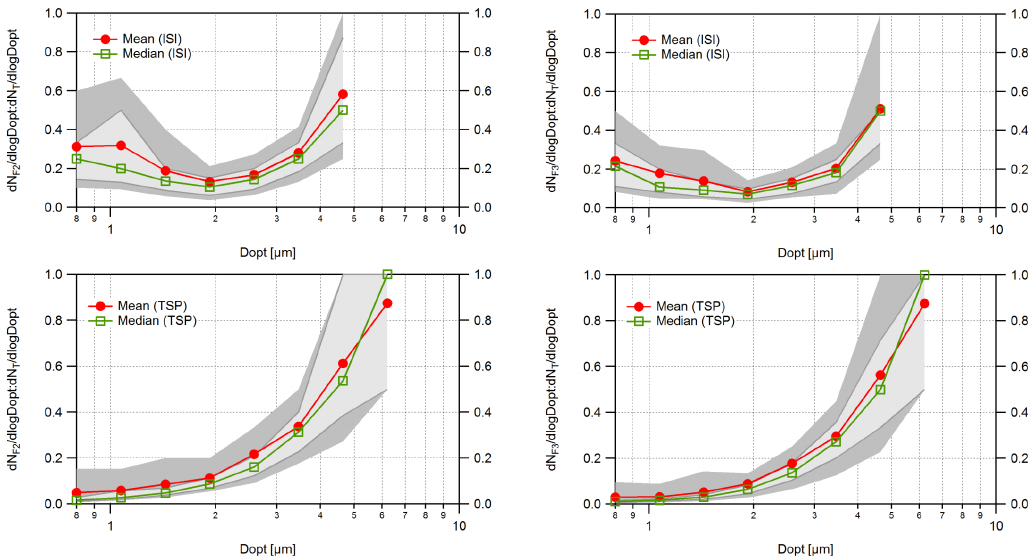
Figure 16. Ratio of fluorescent to all particles measured by the WIBS in two fluorescence channels (F2 in the left panels and F3 in the right panels) as a function of optical particle diameter during CLACE 2014 downstream of the ISI (upper panels) and the total inlet (lower panels) during a Saharan dust event on 18–19 February 2014. The median values are given by the green line, the mean values by the red line, the 25th and 75th percentiles by the light grey shaded area and the 10th and 90th percentiles by the dark grey shaded